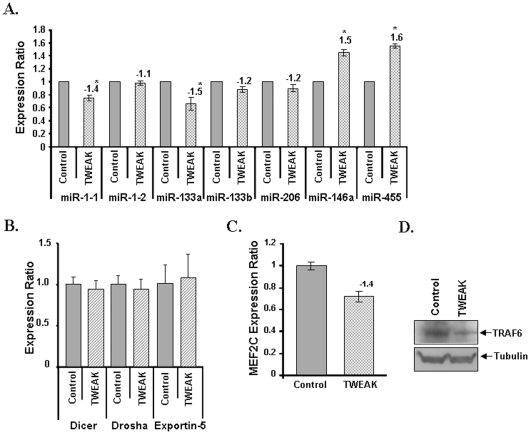
Validation of differentially expressed miRs and their regulatory enzymes by QRT-PCR in TWEAK-treated C2C12 myoblasts.
A). TaqMan qRT-PCR analysis of miR-1-1, miR-1-2, miR-133a, miR-133b, miR-206, miR-146a, miR-206, miR146a, and miR-455 in TWEAK-treated C2C12 cells. The normalized expression ratios were plotted for each miRNA are mean ± SD (n = 3). The numbers above the bar represents the fold changes with TWEAK treatment against control ‘*’ represents the statistical significance (p-value ≤0.01). B). QRT-PCR analysis showed no significant difference in the expression ratio of Dicer, Dorsha and Exportin-5 between control (n = 3) and TWEAK-treated myotubes (n = 3). C). TWEAK-treatment significantly reduced the expression of MEF2C transcription factor. The relative expression values were plotted for MEF2C are mean ± SD (n = 3). D). C2C12 myotubes were treated with 10 ng/ml of TWEAK for 18h followed by isolation of total protein and performing Western blot. Equal amounts of proteins were loaded on 10% SDS-PAGE gel. Representative immunoblots from two independent experiments presented here showed that TWEAK significantly reduced the protein level of TRAF6 in C2C12 myotubes.